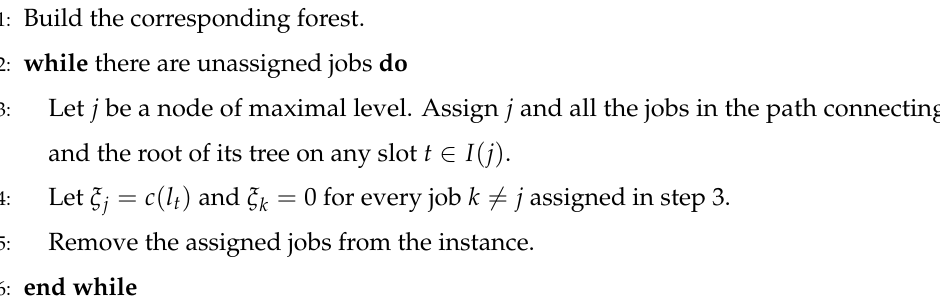
Algorithm 2 An algorithm for finding a NE schedule such that cost ( s ) = OPT for Laminar